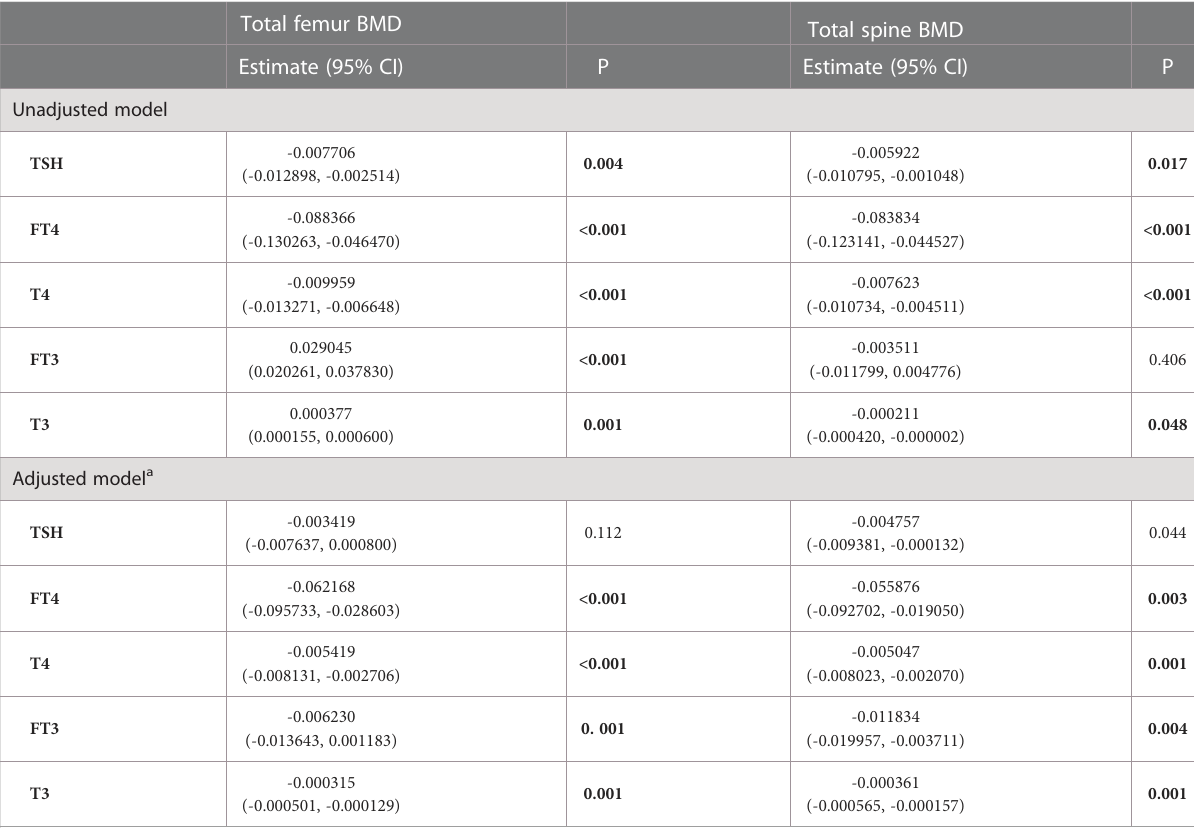
TABLE 2 Association of the thyroid hormone pro fi le with BMD in NHANES, 2007 –